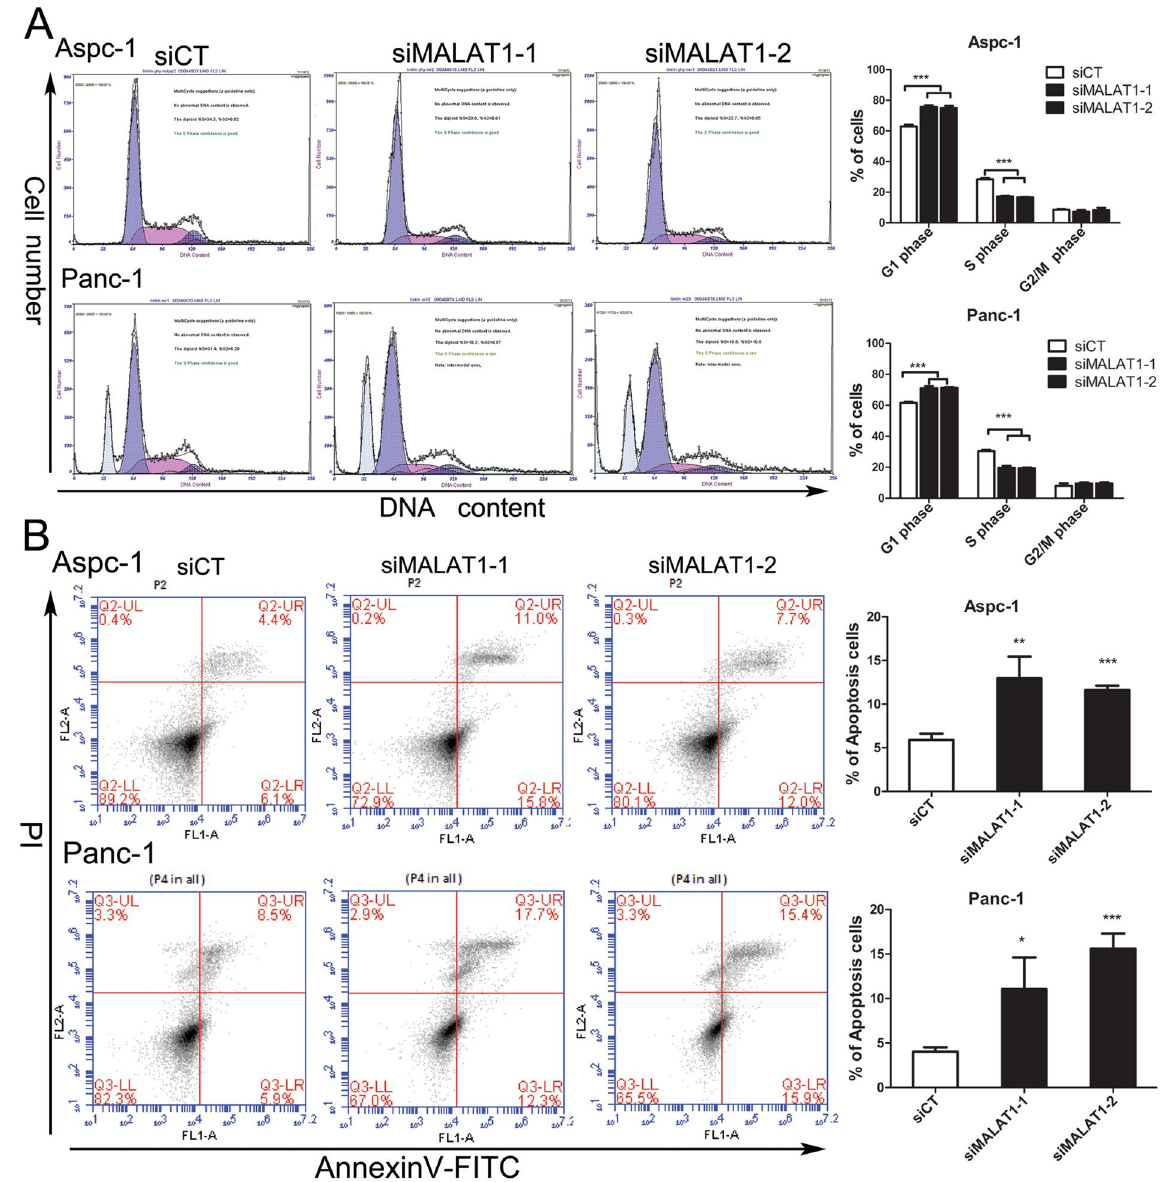
Figure 3. MALAT1 knockdown inhibits cell cycle progression and promotes cell apoptosis. ( A ) Effects of MALAT1 knockdown on cell cycle progression in pancreatic cancer cells (PI staining). ( B ) Effects of MALAT1 knockdown on cell apoptosis in pancreatic cancer cells (Annexin V-FITC staining). All the quantitative results in this study are presented as the mean ± standard error of the mean of at least three replicate determinations of each data point. * p < 0.05, *** p < 0.001 for siMALAT1 vs